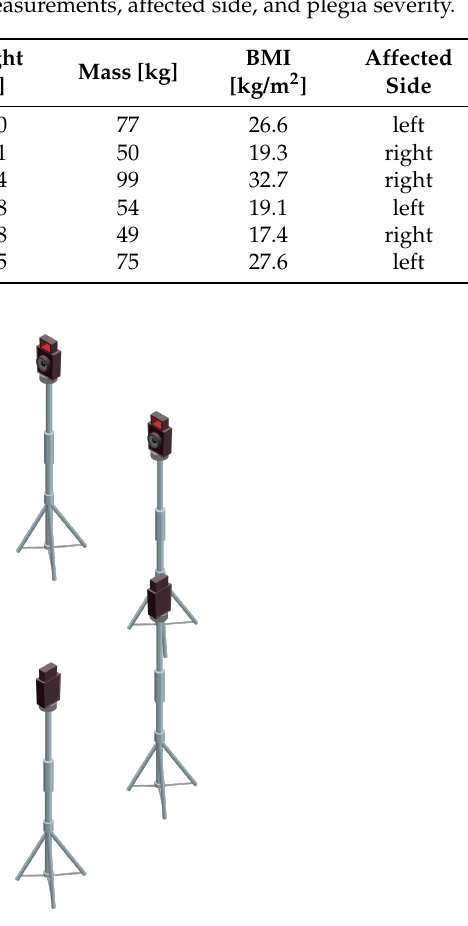
Figure 4. Schematic representation of the experimental setup showing the subject sitting on a stool in the center of the room wearing the WD and the photoreflective markers (grey spheres on the chest wall) surrounded by the mocap